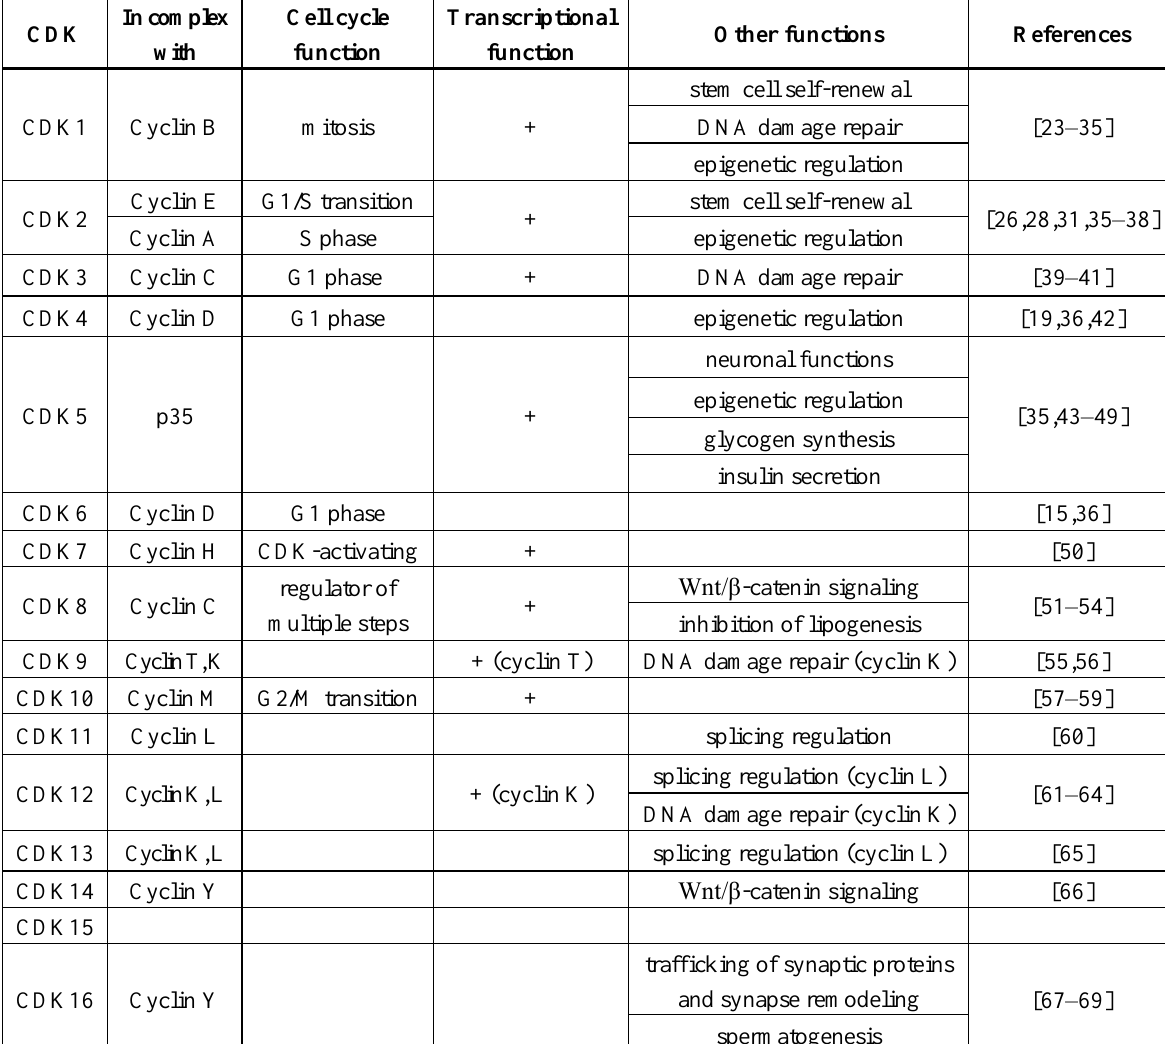
Table 1. Functions of